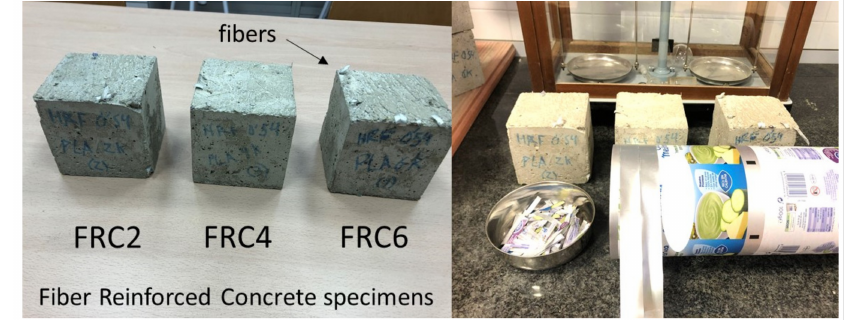
Figure 2. Concrete specimens of FRC with RPF: FRC2, FRC4 and